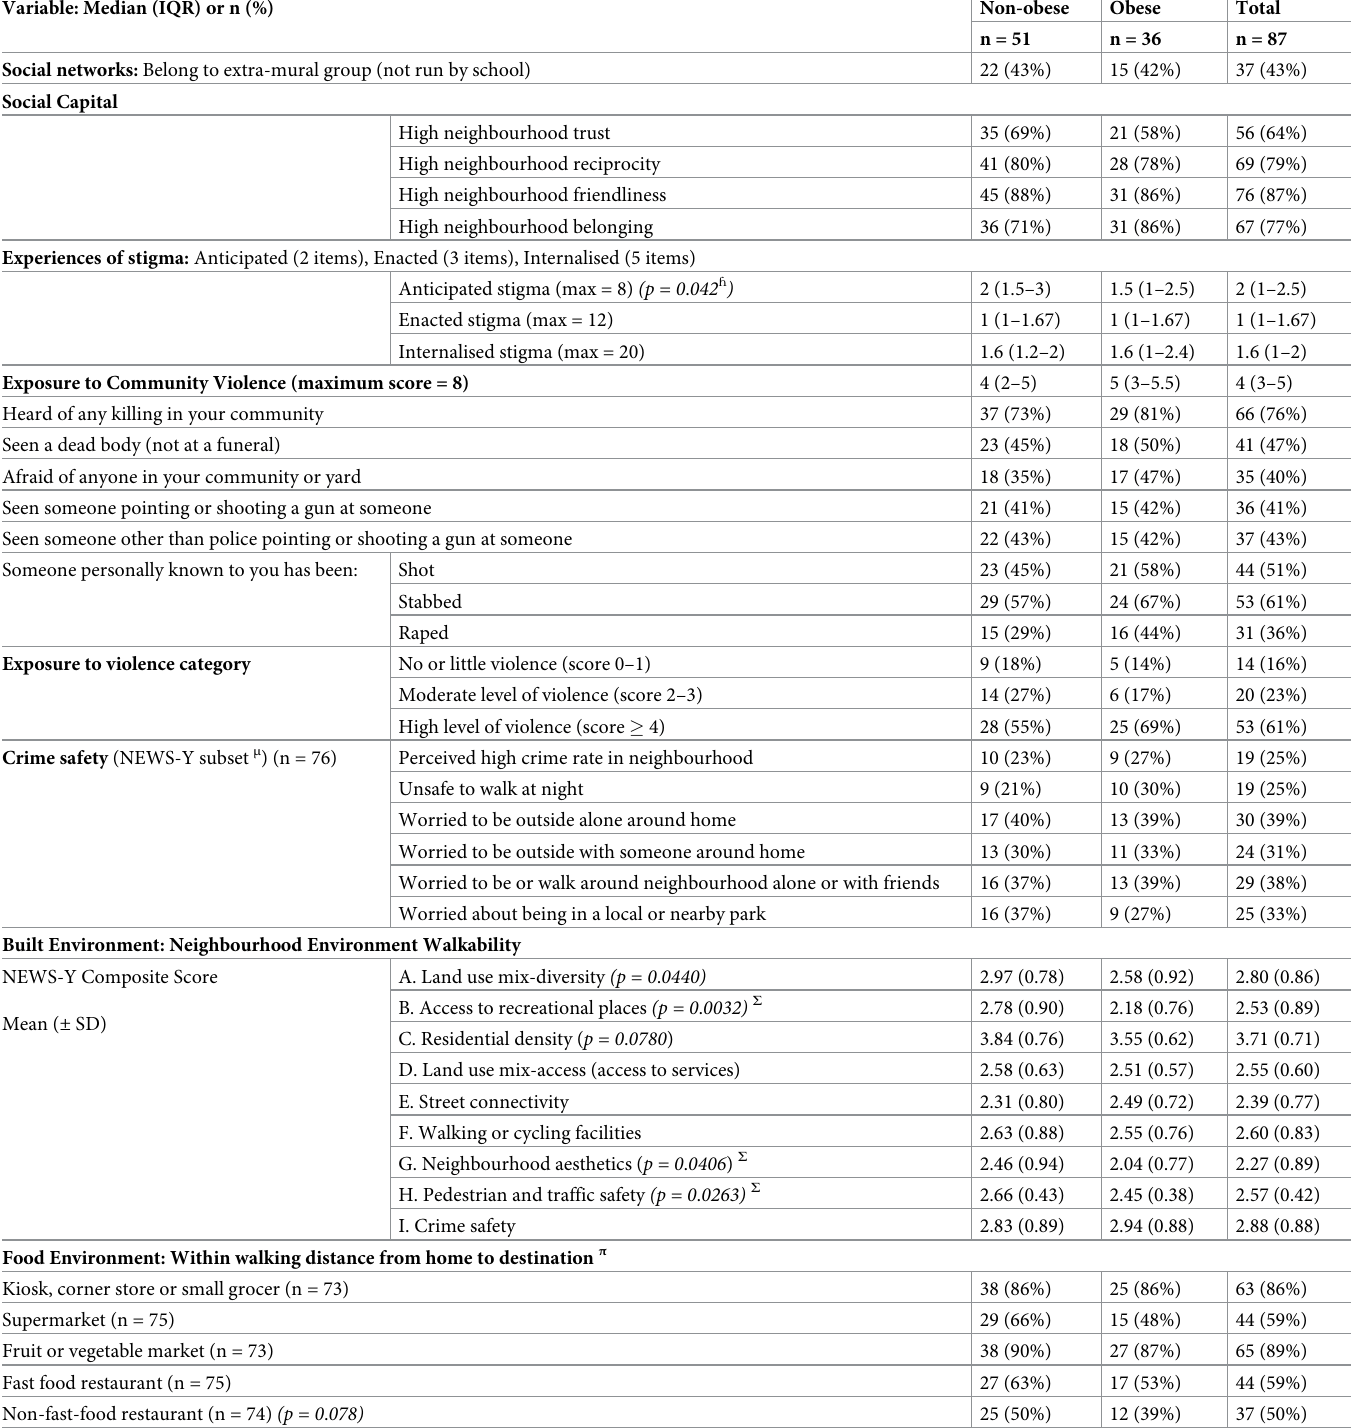
Table 3. Community and built environment characteristics of AYLHIV by abdominal obesity status. Variable: Median (IQR) or n